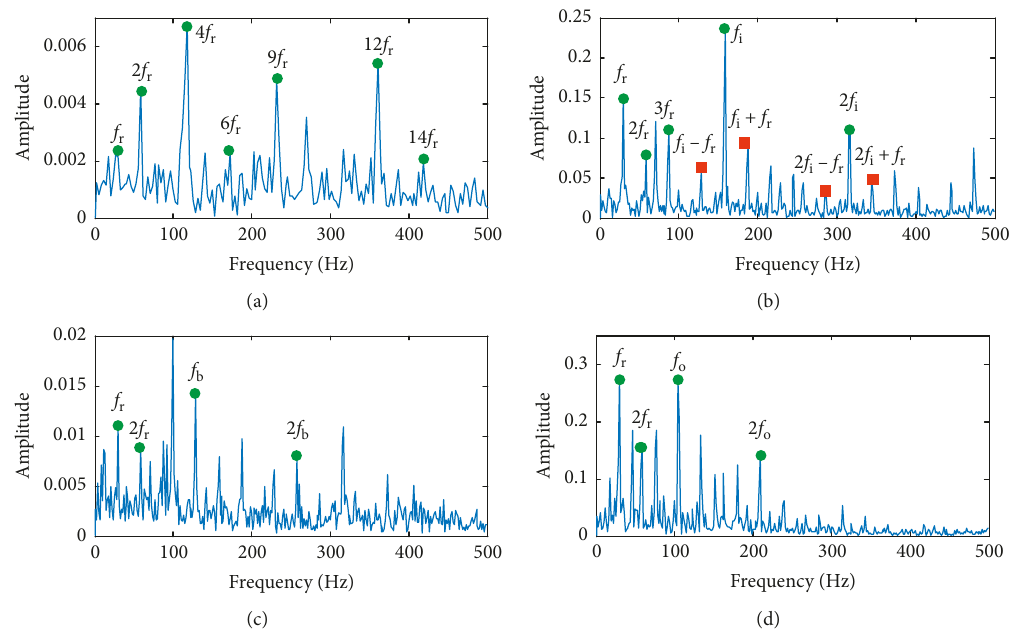
Figure 5: The Frequency domain diagram of CWRU signals, where (a)–(d) are corresponding to signals in Figure 5, respectively. The characteristic frequency distinction of each fault form is quite obvious, especially in (a) and (b) for the normal signal and the inner race fault signal. It is easy to find out the AM frequency in (b). However, there are a lot of interference frequency components in the spectrum of the roller fault signal and outer race fault signal, as in (c) and (d). Moreover, the FM components (by the cage frequency) of the ball frequency cannot be